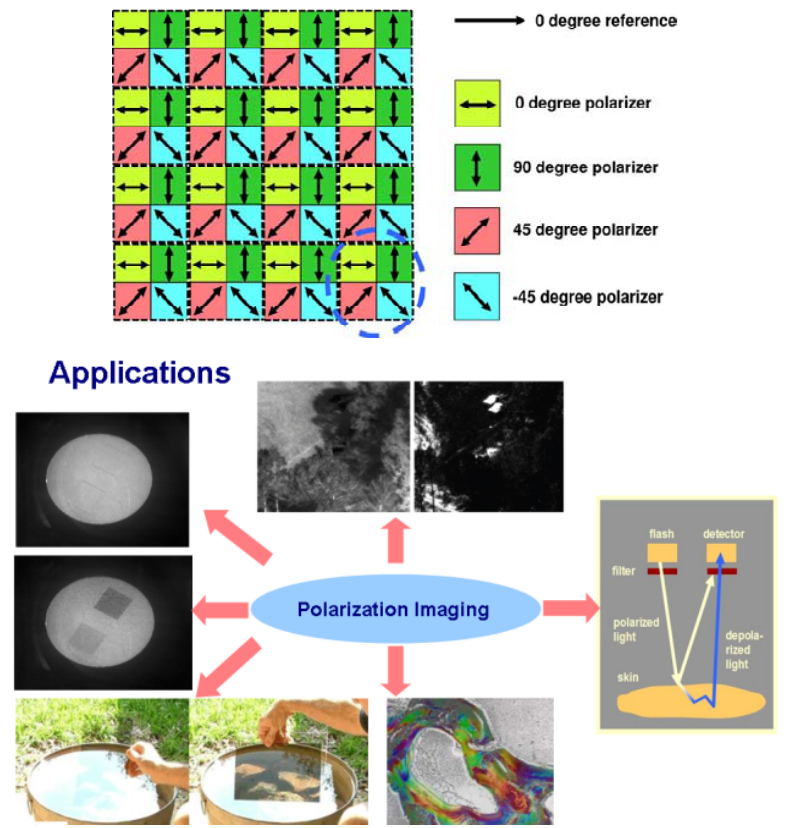
Figure 6. A thin photopatterned micropolarizer array for complementary metal-oxide-semiconductor (CMOS) image sensors for simultaneous detection of all four Stokes parameters of output optical image, including “invisible objects” (constant transmission or reflection and no color)